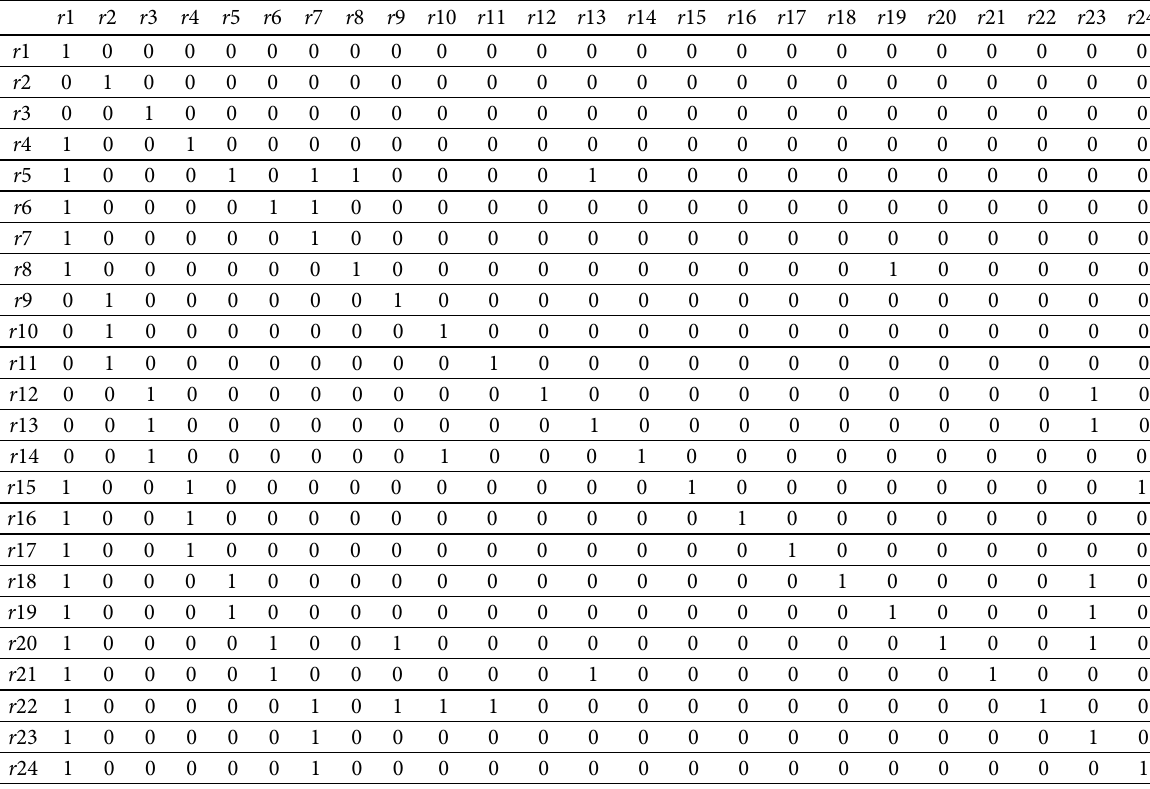
Table 2. The reachability matrix of system elements